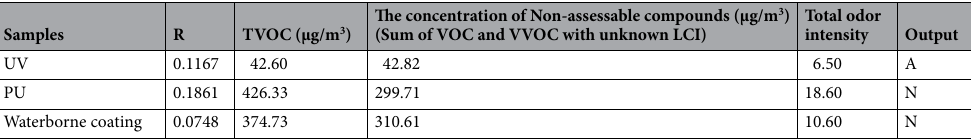
Table 5. Index value and result output of Xylosma racemosum (Sieb. et Zucc.) Miq. decorated with different lacquer decorations.